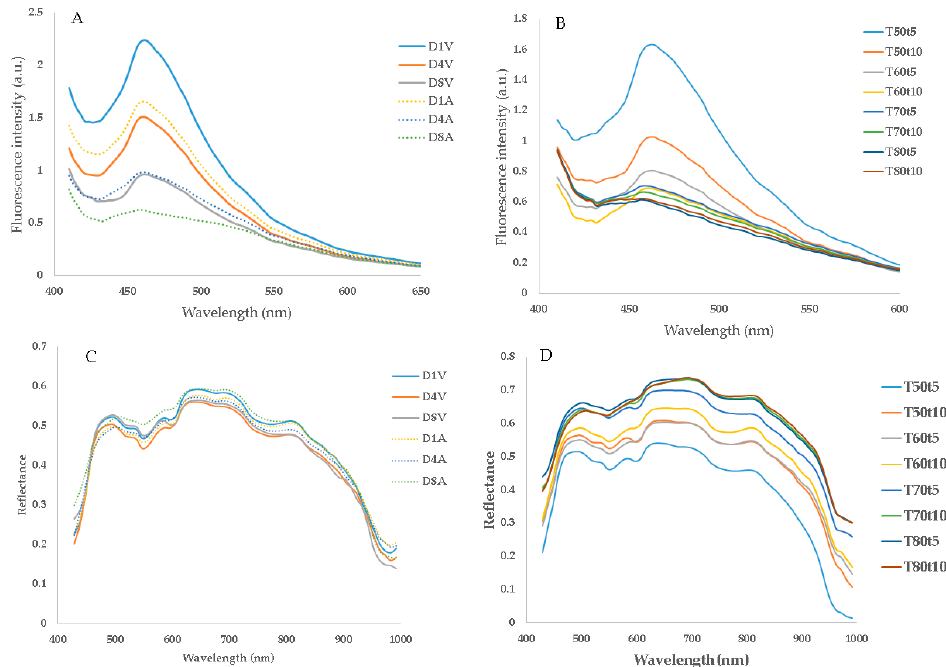
Figure 4. Mean fluorescence ( A , B ) and di ff use reflectance ( C , D ) spectra of the control (A and C) and the heat treated samples (B and D), obtained as a function of storage days (D), packaging types (V; vacuum-packed samples, A; air-packed samples), and cooking conditions; cooking temperature; T, cooking time; t.